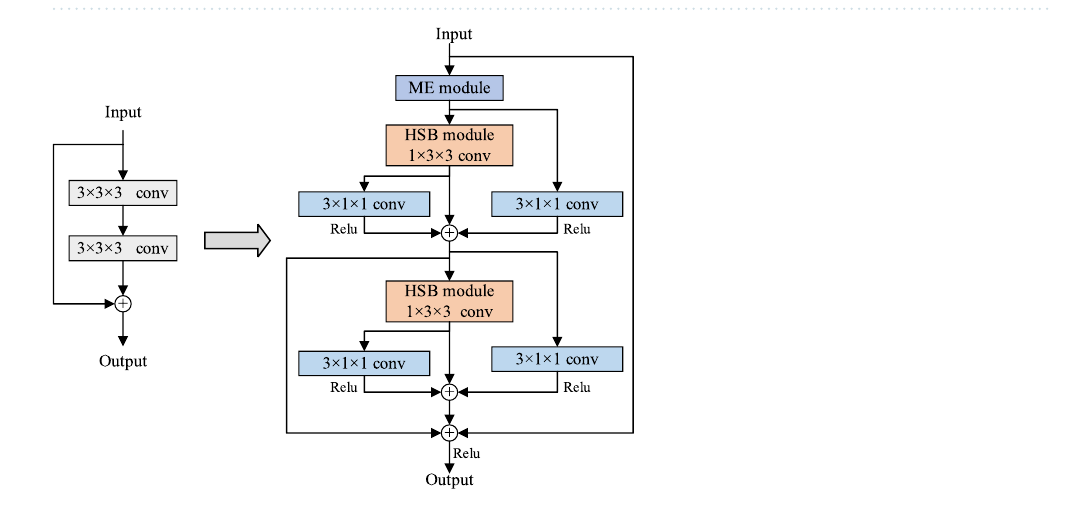
Figure 10. Improved 3D-ResNet18 network algorithm pseudocode.